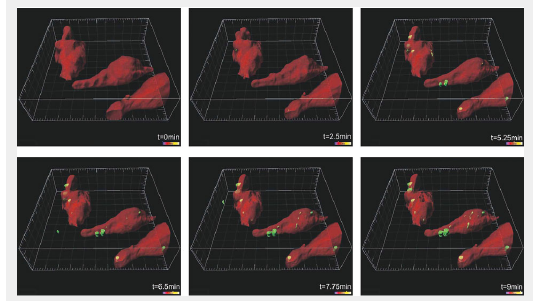
Uptake of polystyrene particles by MDM. MDM was pre-labelled with Cell tracker orange (red, transparent volume rendering). Fluorescently labelled polystyrene particles (1 µm, green, surface rendering) were added at time point zero to the cultures and visualized for 10 minutes using a Zeiss Duo5 laser scanning microscope with the line scan modus at a z-interval of 0.3 µm. The data restoration was done with IMARIS from Bitplane AG.